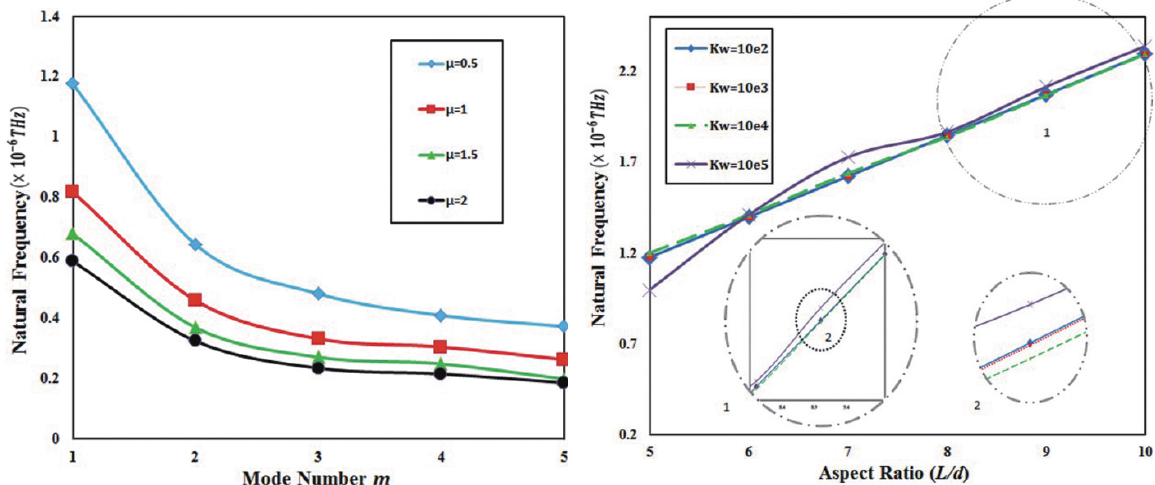
Fig. 5. The effect of mode number on natural frequency for different nonlocal parameter μ , ( K W = 10 3 N/m 2 , L/d = 5).